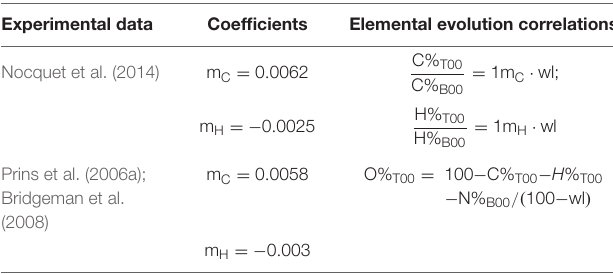
TABLE 4 | Literature reported solid elemental evolution models (Peduzzi et al., 2014)